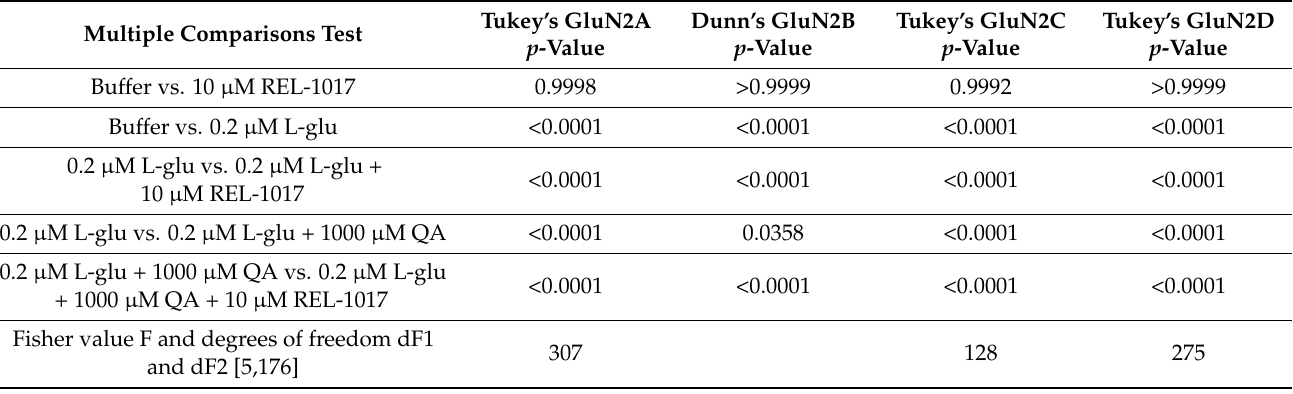
Table 3. Statistical significance of values reported in Figure